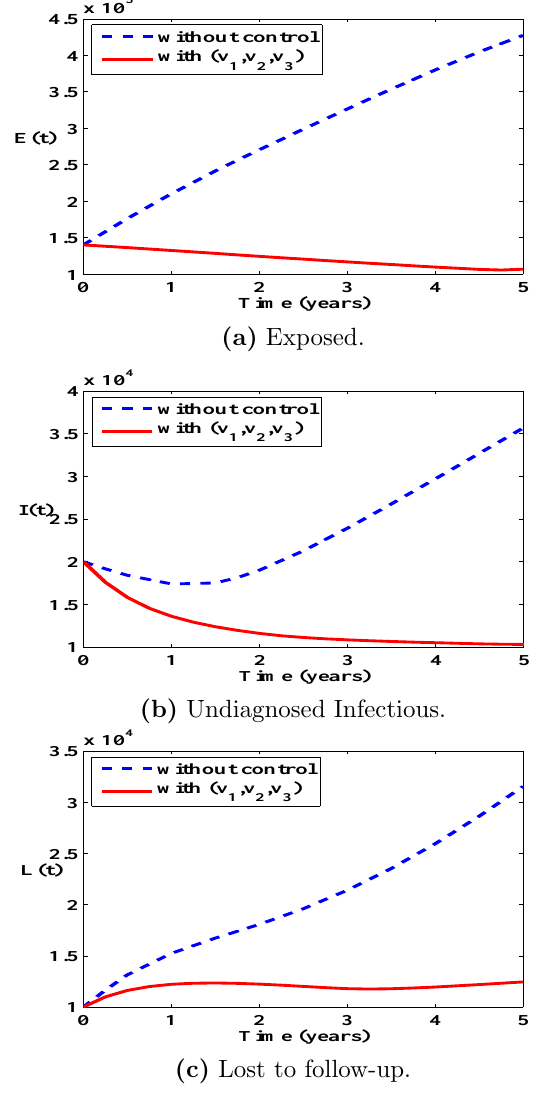
Figure 8. Number of E , I and L with controls v 1 , v 2 , v 3 and without